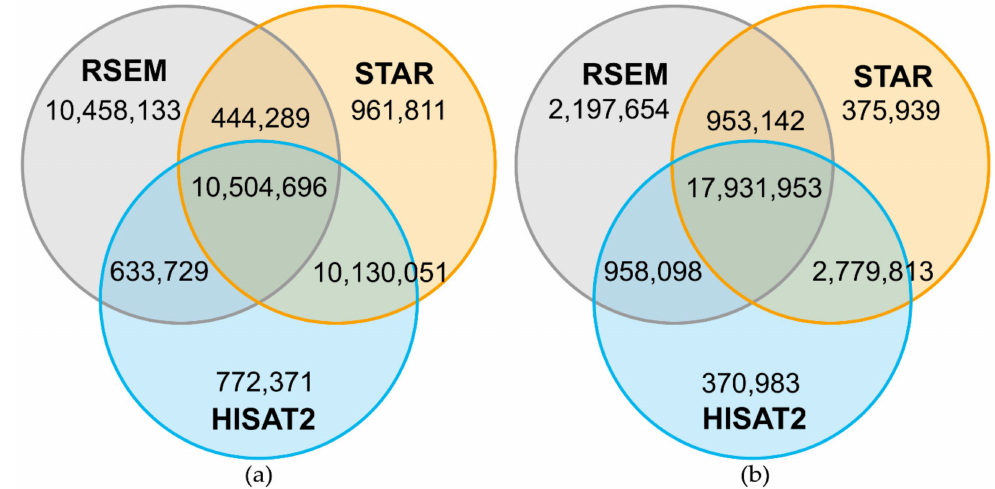
Figure 7. Number of reads mapping on the same genomic position comparing HISAT2, RSEM and STAR for N14. Venn diagrams are based on 22,040,847 reads mapped by all three mappers and represent the overlap of mapped reads on the same genomic position for sample B (see Table A3 for sample information). A high number of the uniquely mapped reads in RSEM was based on soft-clipping by one bp performed by HISAT2 and STAR ( a ). The reads in HISAT2 and STAR were corrected by adding the soft-clipped bp back and the overlap with RSEM increased strongly ( b ).